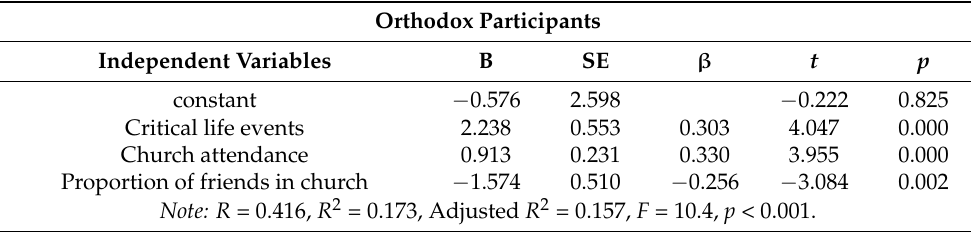
Table 11. Stepwise regression analysis on prediction of negative religious